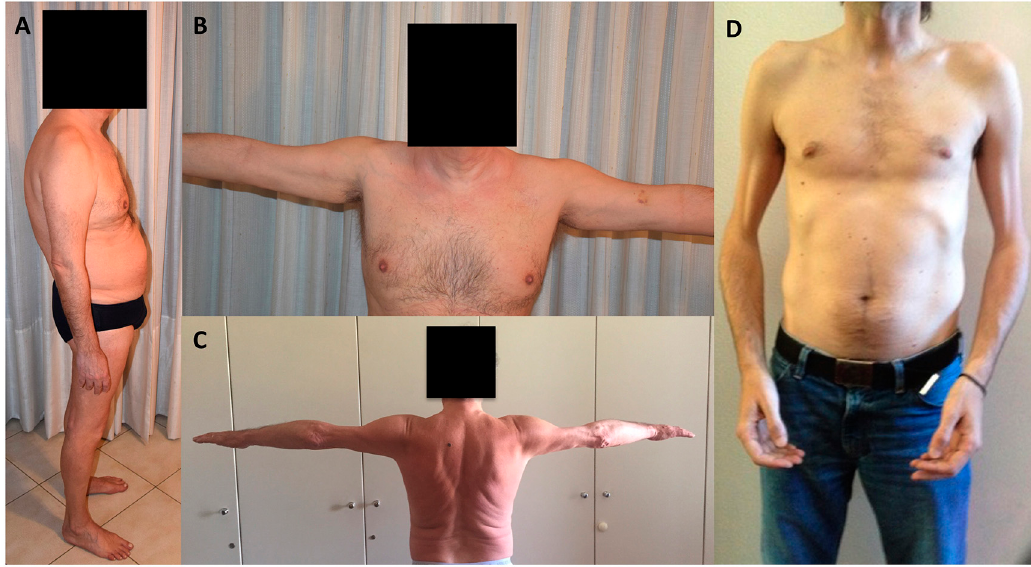
Figure 1. Description of typical clinical features of LMNA -related dystrophy ( LMNA -RD). Patient affected by LGMD1B phenotype: note the lumbar lordosis ( A ) and upper limb abduction weakness ( B ); patient with LGMD1B: note the humeral atrophy and absence of scapular winging, which is typically associated with EDMD2 ( C ); patient affected by EDMD2 phenotype: note the elbow flexion contractures and wasting of humeral muscles ( D ).